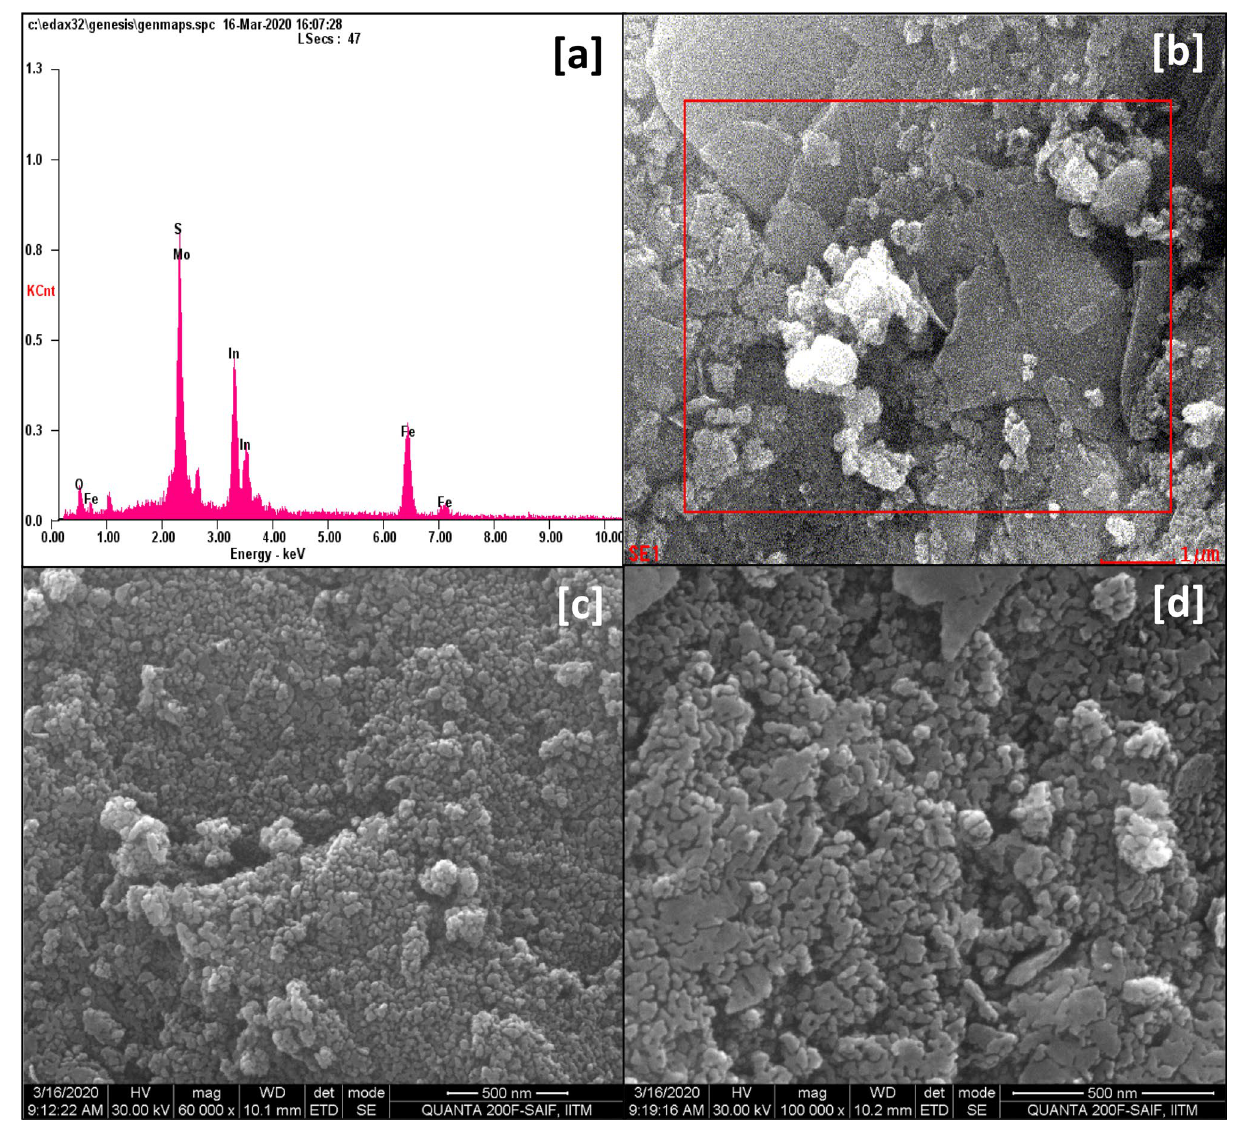
Figure 4. ( a ) EDAX spectrum of In 2 O 3 /MoS 2 /Fe 3 O 4 . ( b ), ( c ) and ( d ) SEM micrographs of In 2 O 3 /MoS 2 /Fe 3 O 4 .